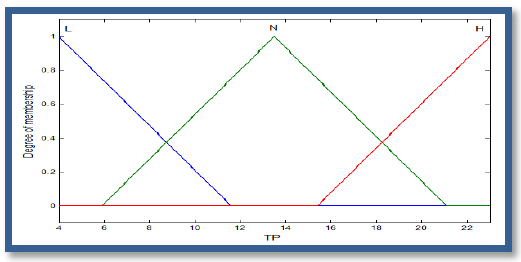
Fig. 5. Fuzzy set and membership functions related to temperature (T) – primary model